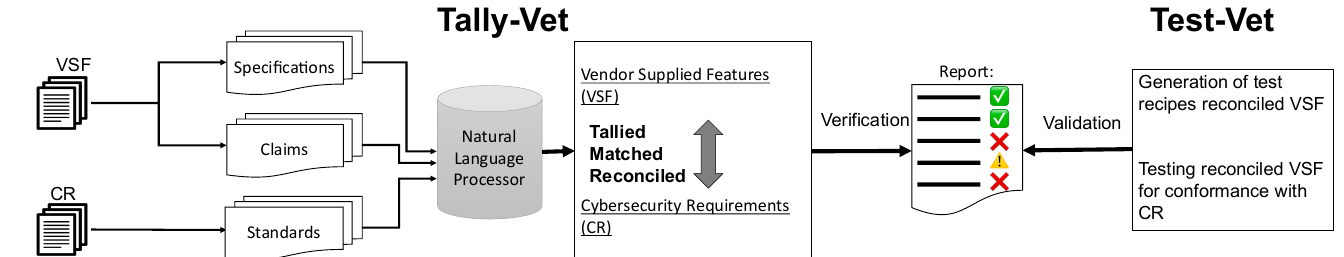
Figure 1. Overall workflow of the CYVET cybersecurity vetting